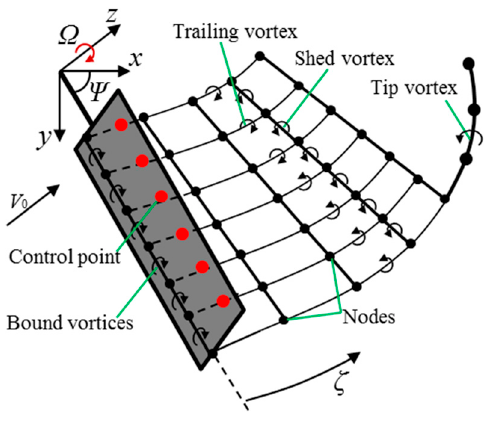
Figure 2. Schematic of the blade model and the vortex wake model.